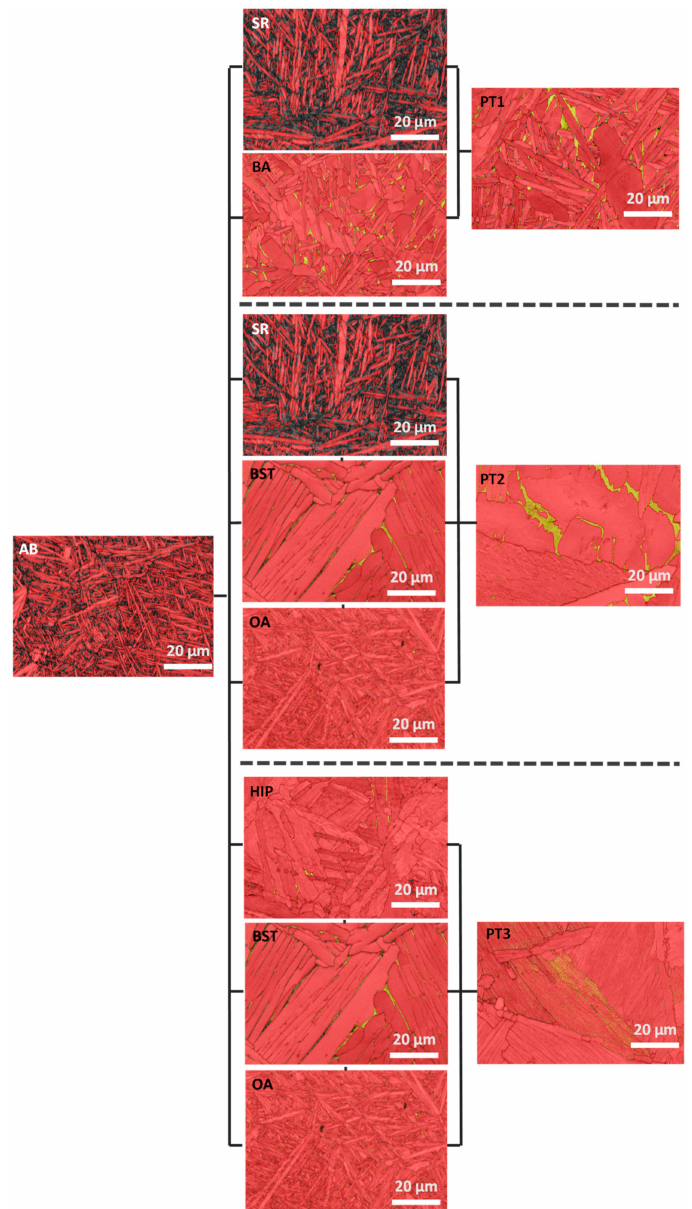
Figure 5. EBSD phase maps of each stage of the PT protocols: α phase in red, β phase in yellow, and unresolved (deformed or containing high residual stresses) structure in